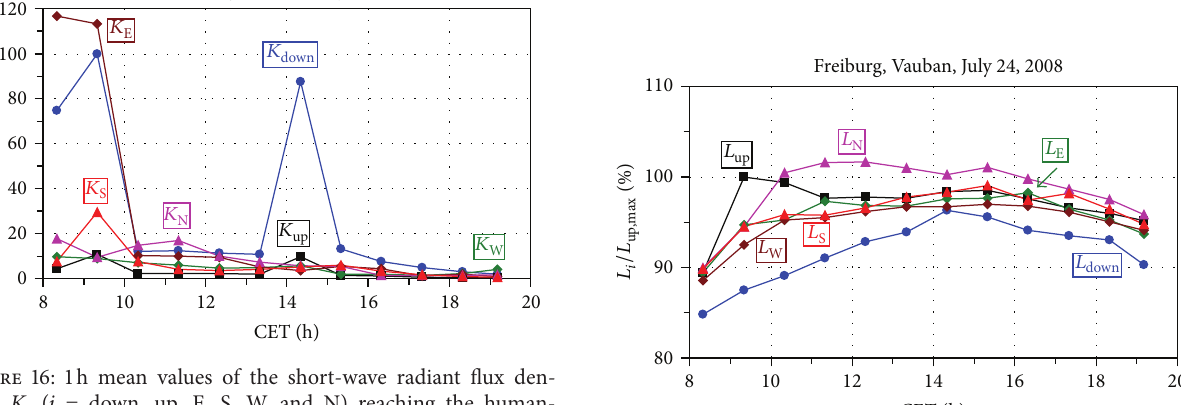
Figure 16: 1h mean values of the short-wave radiant flux den- sities 𝐾 𝑖 ( 𝑖 = down, up, E, S, W, and N) reaching the human- biometeorological reference person from the three-dimensional environment, related to the 1h peak value of 𝐾 600 W/m 2 ), SSW-facing sidewalk (shaded by tree canopies) of a WNW-ESE street canyon, “Vauban” quarter in Freiburg during typical Central European summer day.